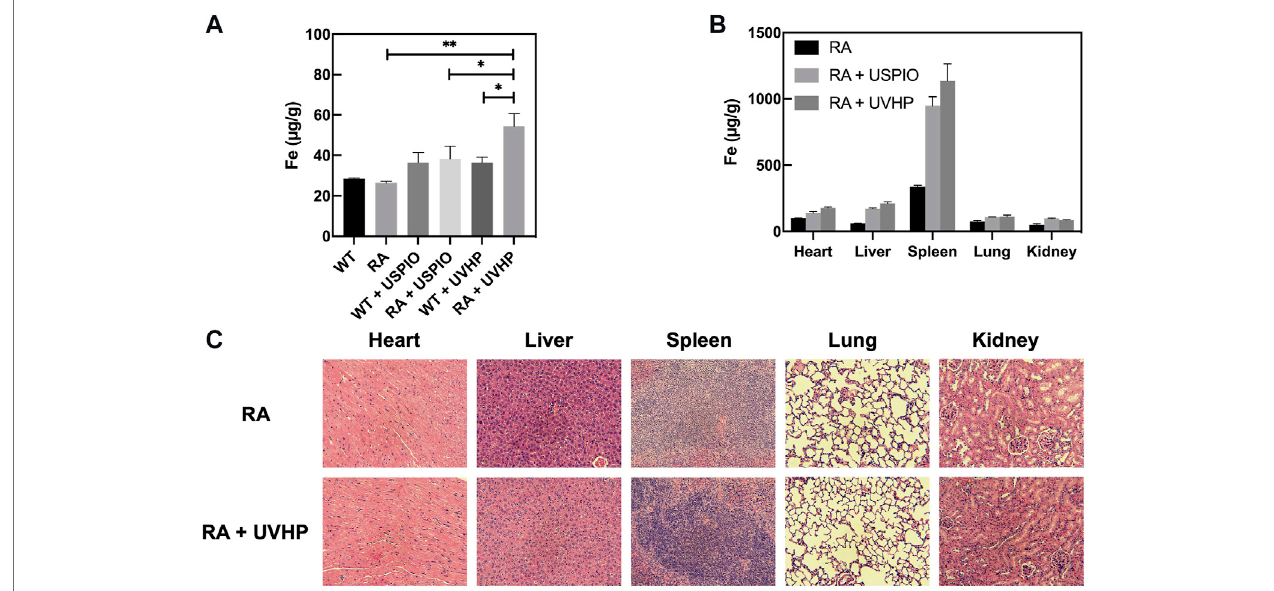
FIGURE 6 | Fe content in different tissues. (A) Elemental Fe content in the knee joint 24 h after tail vein injection of USPIO, UVHP to RA mice, WT mice, and PBS- injectedRAmice,withWTmiceascontrol.Eachgroup( n =3pergroup)wasinjectedwithanequalFeconcentration(250 µgFe,in0.1 mLPBS). (B) BiodistributionofFe in the major organs (heart, liver, spleen, lung, kidney) in RA mice (n = 3) at 24 h after intravenous administration of the USPIO, UVHP (250 µg Fe, in 0.1 mL PBS). The Fe content of each organ was measured by ICP-OES. RA mice ( n = 3) injected with PBS served as controls. (C) Sections of each organ (heart, liver, spleen, lung, kidney). The tail vein of RA mice (n = 3) was injected with UVHP (Fe contains 250 µg in 0.1 mL PBS), and H&E staining of each organ (heart, liver, spleen, lung, kidney) was performed after 14 days. RA mice ( n = 3) injected with saline served as